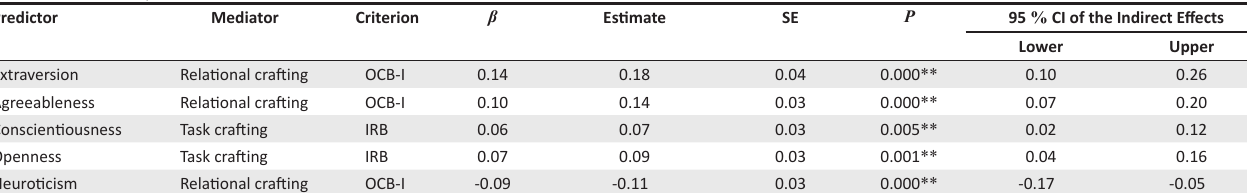
TABLE 2: Test of unique indirect relations.